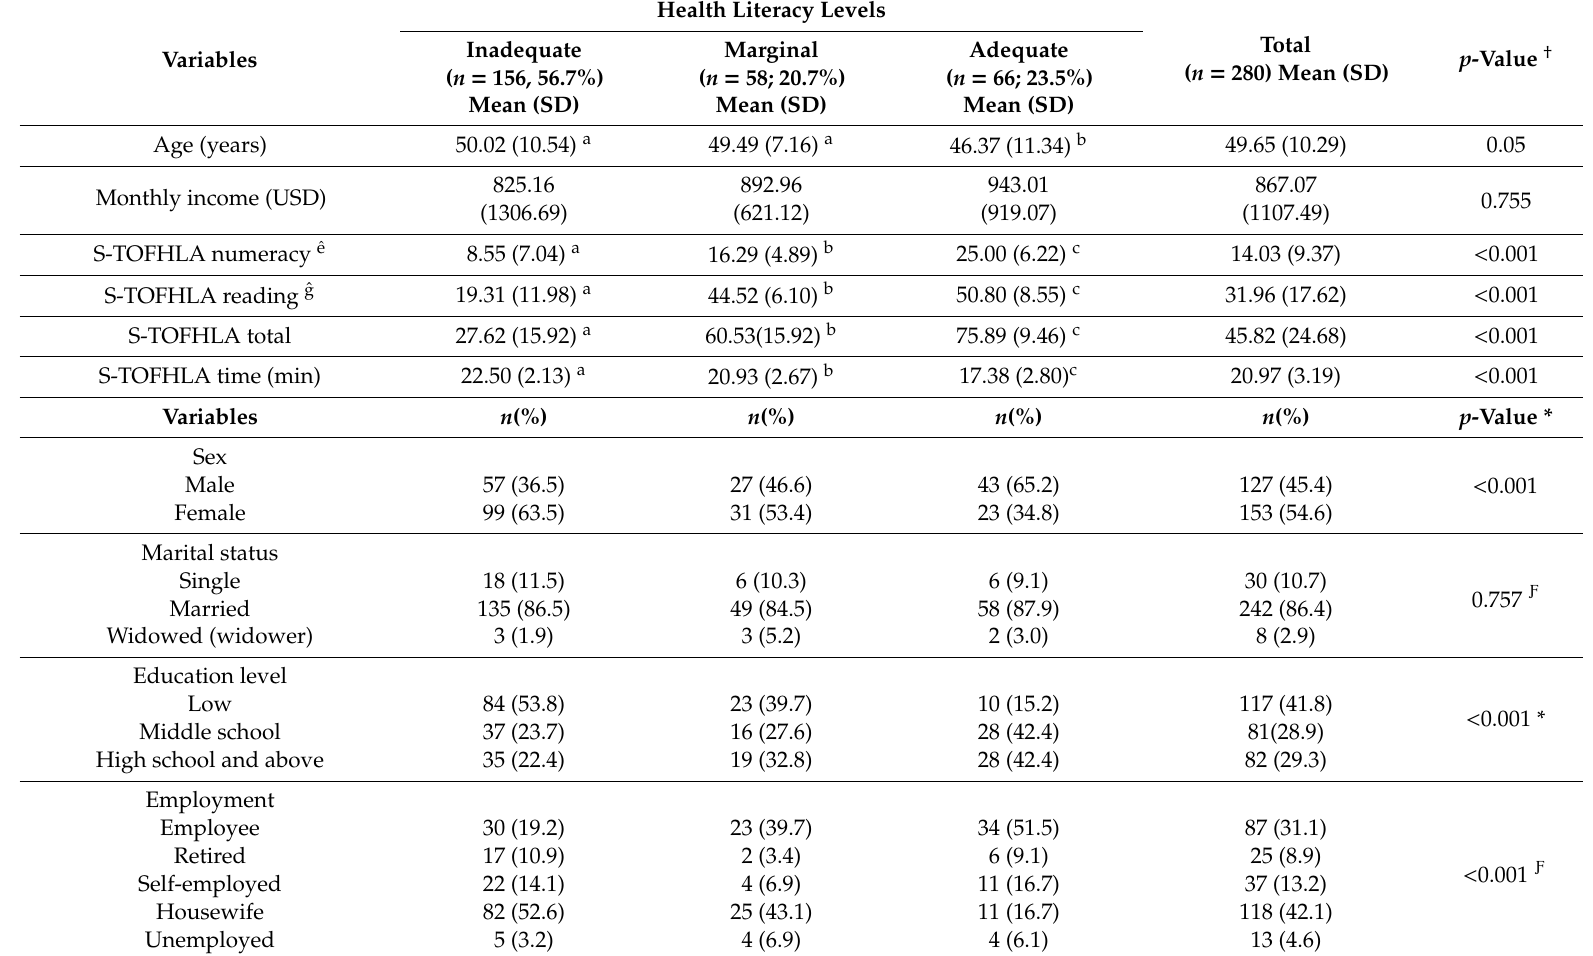
Table 1. Socio-demographic and medical status of respondents according to the health literacy